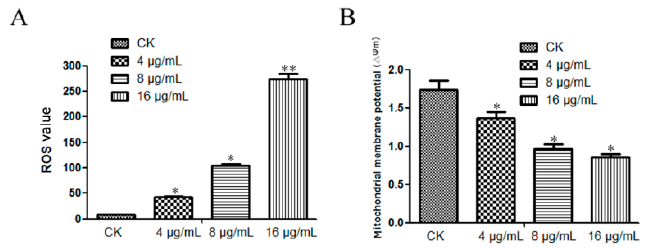
Figure 3. The ROS value and mitochondrial membrane potential detection: ( A ) ROS value; ( B ) mito- chondrial membrane potential. The TA treatment can elevate the ROS value and down-regulate the mitochondrial membrane potential. “*” indicates p < 0.05, “**” indicates p < 0.01.